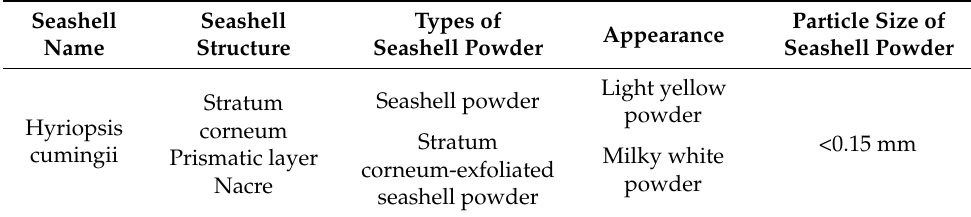
Table 4. Surface energy parameters of reagents.